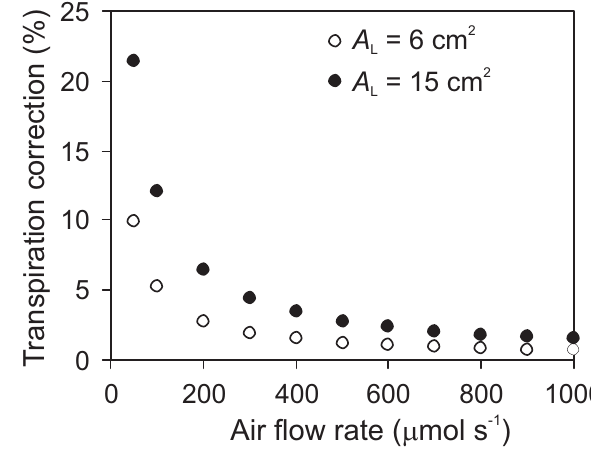
Fig. 7. Simulation of the effect of transpiration correction (Eq. 14) on the emission rate in dependence on the incoming air flow rate for cuvettes enclosing 6cm 2 and 15cm 2 leaf area. In these simulations, we used a moderately high transpiration rate of 9mmolm − 2 s − 1 , incoming BVOC concentration of 3nmolmol − 1 and an emission rate of 12nmolm − 2 s − 1 . For given air flow rate and leaf area, the correction is the larger the larger is the leaf transpiration rate and the larger is the BVOC concentration in incoming